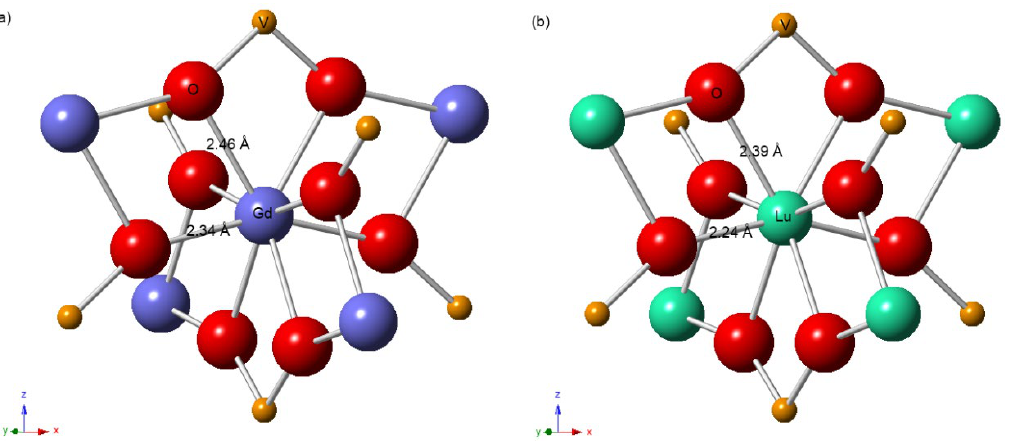
Figure 4. Distribution of neighboring atoms of the first three shells of the central ( a ) Gd atom in GdVO 4 and ( b ) Lu atom in LuVO 4 with the zircon-type structure; the annotated interatomic distances of the first coordination shell were obtained from EXAFS.